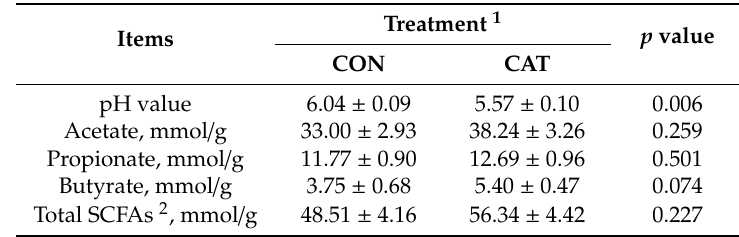
Table 6. E ff ects of dietary exogenous catalase supplementation on short-chain fatty acids concentration and pH values in the colonic digesta of weaned piglets.